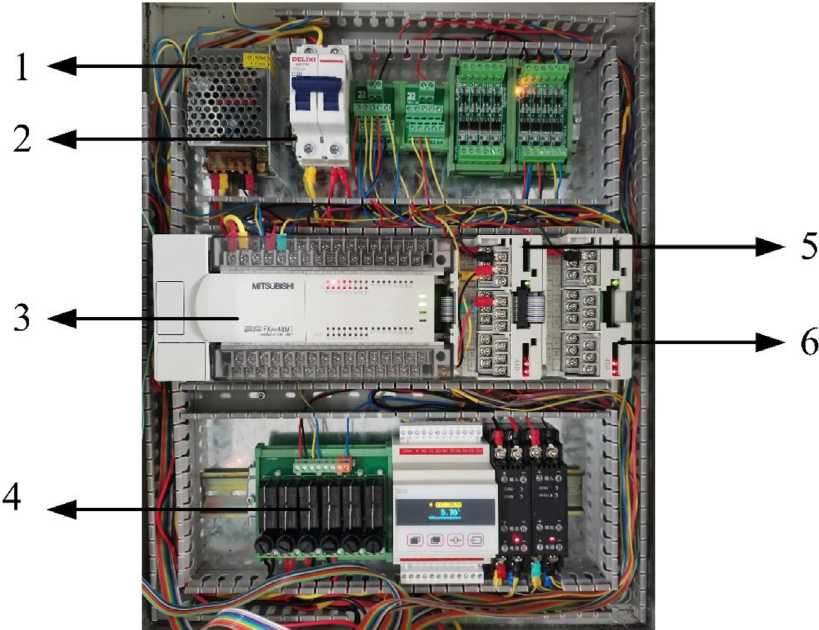
Fig. 15. Physical picture of control box. 1. Transformer. 2. Circuit breaker. 3. FX2N-48MT. 4. Relay group. 5. FX2N-4DA. 6. FX2N-